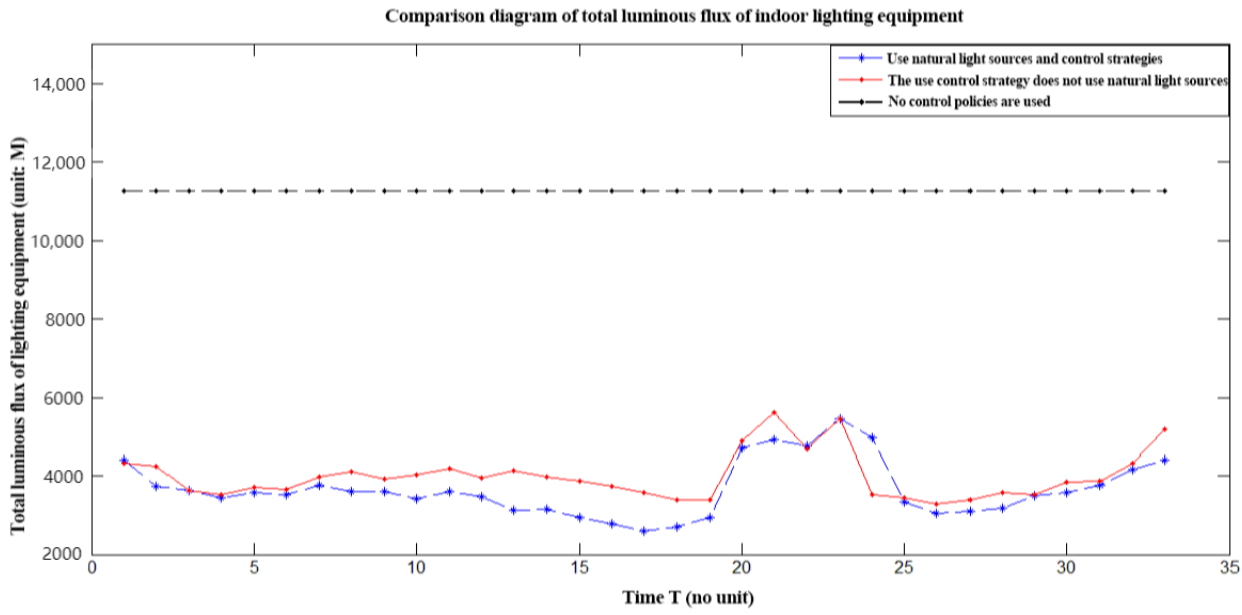
Figure 13. Comparison of the total luminous flux of indoor lighting equipment.